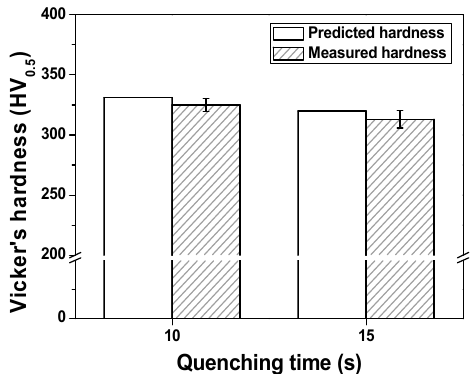
Figure 14. Comparison between predicted and measured hardness at heated tool temperature of 420 °C and quenching time of 10 s and 15 s.